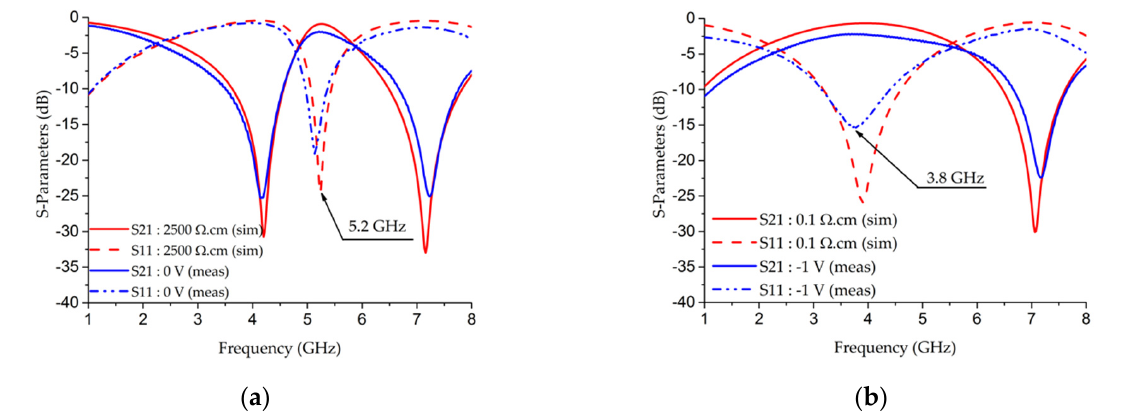
Figure 12. Comparison of simulated and measured results of switchable DBR 4 . ( a ) in the OFF state; ( b ) in the ON state.